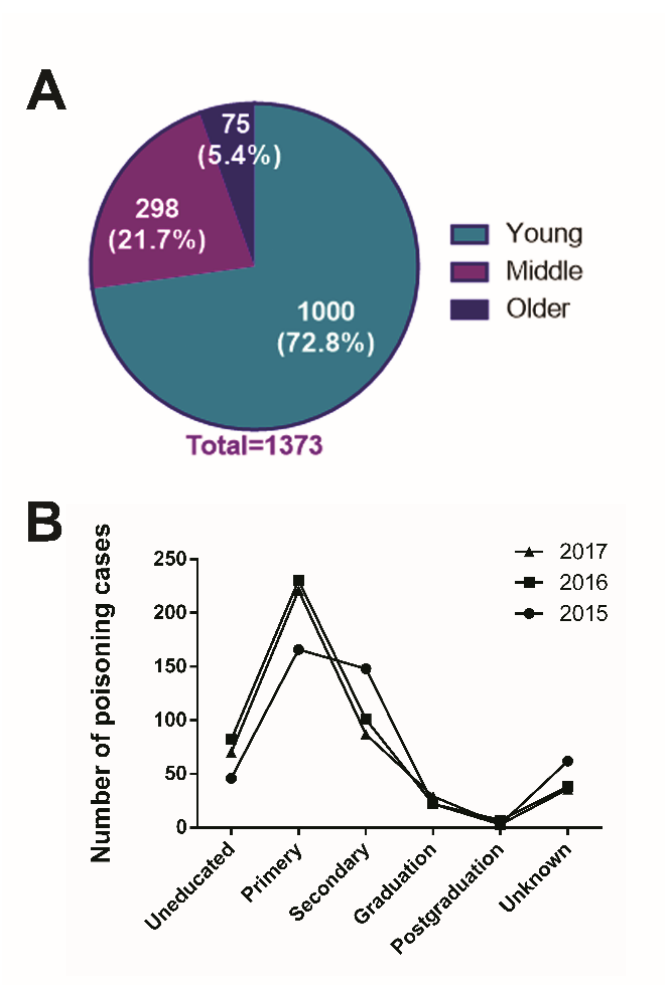
Figure 1. The pie chart shows the number of poisoning incidences in young, middle and older aged subjects (A) and educational status of the patients (B) between 2015 and